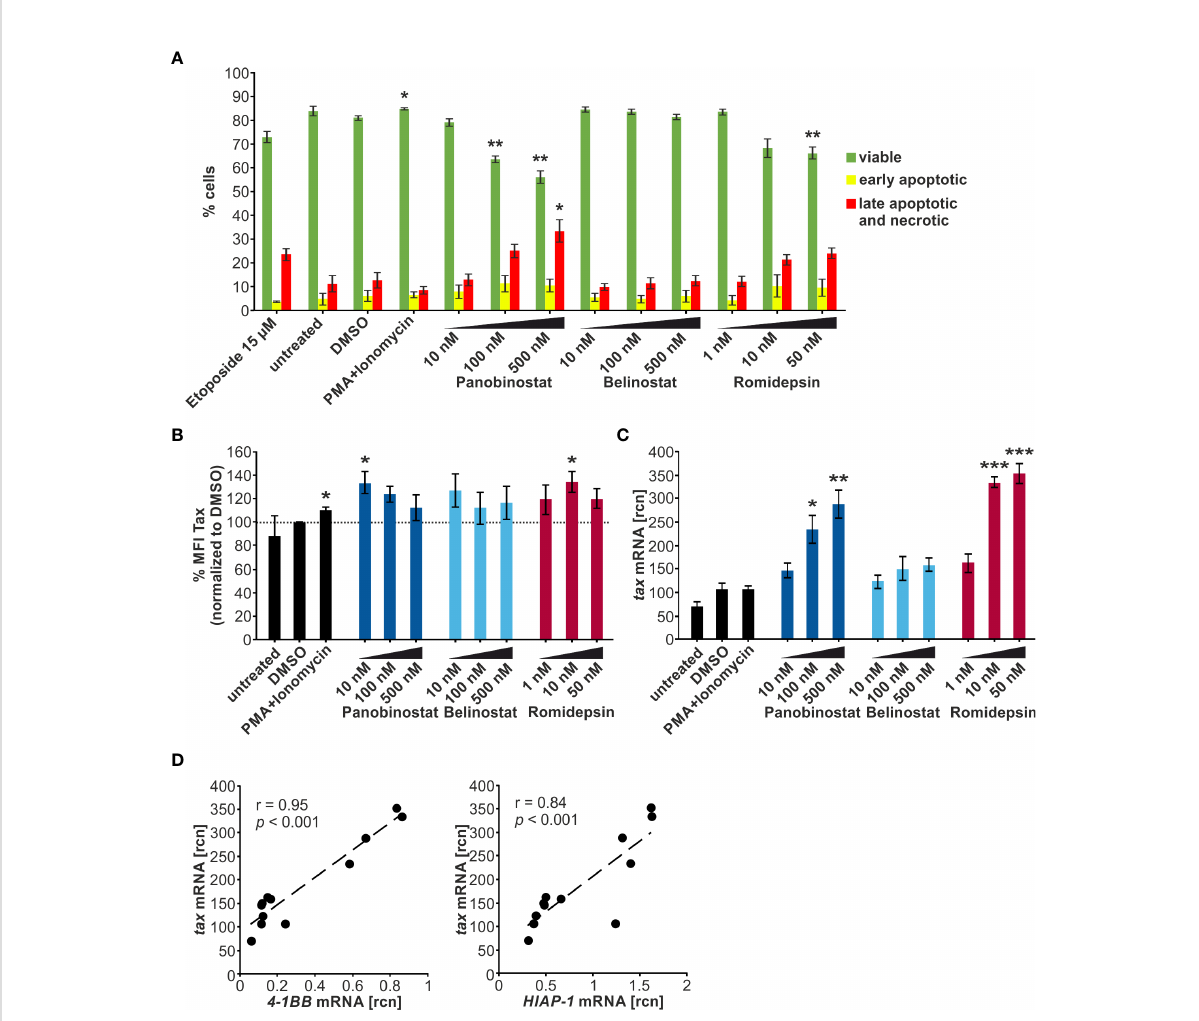
FIGURE 4 Panobinostat, Belinostat, and Romidepsin dose-dependently increase tax transcripts, but only mildly Tax protein in chronically HTLV-1-infected cells. (A – D) MT-2 cells were treated with increasing concentrations of the HDACi Panobinostat, Belinostat, or Romidepsin as indicated for 24 h. PMA+Ionomycin served as a positive control for activation of latent viral transcription, DMSO served as solvent control. Cells were subjected to (A, B) fl ow cytometry and (C, D) qRT-PCR. (A) Flow cytometry upon staining of cells with the LIVE/DEAD Fixable Far Red Dead Cell Stain Kit and the Annexin V paci fi c blue conjugate. The frequencies of viable cells (double-negative cells; green), early apoptotic cells (LIVE/DEAD - /Annexin V + ; yellow), or late apoptotic and necrotic cells (LIVE/DEAD + ; red) are indicated (gating strategy: Supplementary Figure 3A). Etoposide (15 µM) served as a positive control for induction of apoptosis. Mean percentages of each cell population of three independent experiments ± SE are depicted and were compared to DMSO treatment using Student ’ s t-test (*, p < 0.05; **, p < 0.01). (B) Flow cytometry of Tax protein in living cells. Fold change of arithmetic mean fl uorescence intensities normalized to DMSO of three independent experiments ± SE are depicted, and values were compared to DMSO treatment using Student ’ s t-test (*, p < 0.05). (C) Mean rcn of tax normalized to the housekeeping gene b - Actin , of four independent experiments ± SE were compared to DMSO-treated cells using Student ’ s t-test (*, p < 0.05; **, p < 0.01; ***, p < 0.001). (D) Mean rcn of tax and the Tax-target genes 4-1BB and HIAP-1 , normalized to the housekeeping gene b -Actin , were correlated and subjected to Pearson correlation analysis (Pearson correlation coef fi cient r = 0.95 and r = 0.84 respectively, p = 1.11E-06 and p = 5.37E-04